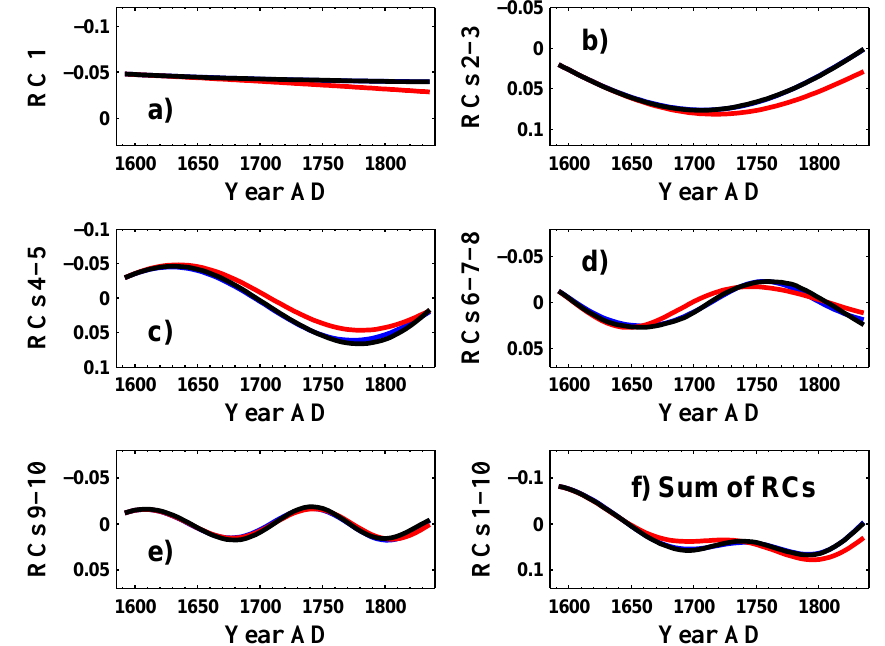
Fig. 4. Prediction results for the low-frequency variability (LFV) portion of the δ 18 O time series over a test section 1592–1840AD that immediately precedes the Industrial Era. The predictions are shown separately for the trend (RC1), for each oscillatory pair of Fig. 2 and for the sum of RCs: observed LFV in black, cf. Eq. (1); SSA-AR prediction in red; and neural-network prediction in blue. See text for details of the prediction methods. Clearly the agreement between the two forecasts and the observed LFV is excellent for a length of time equal to that of the modern, Industrial-Era predictions in the next figure, i.e. out to roughly 1730AD; it deteriorates only slightly beyond this range, i.e. for the latter part of the test section